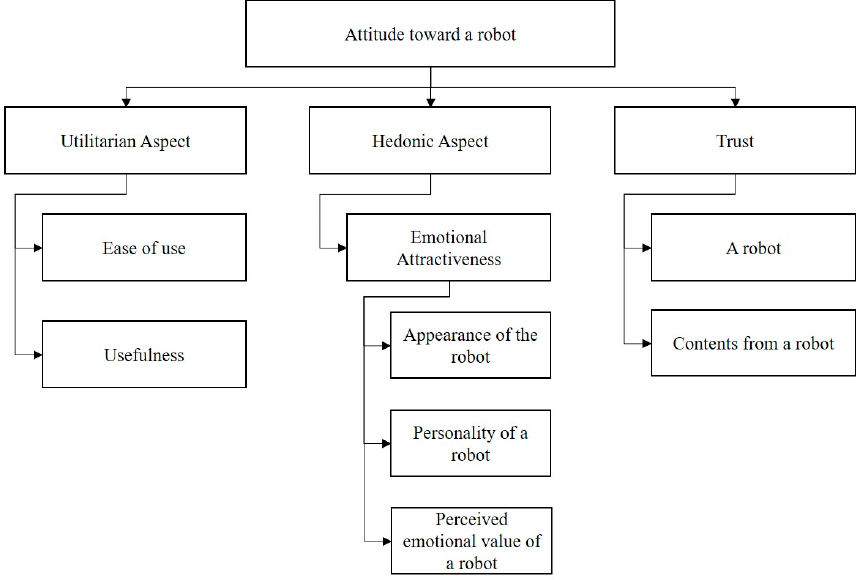
Figure 2. Dimensions of attitude toward a robot.